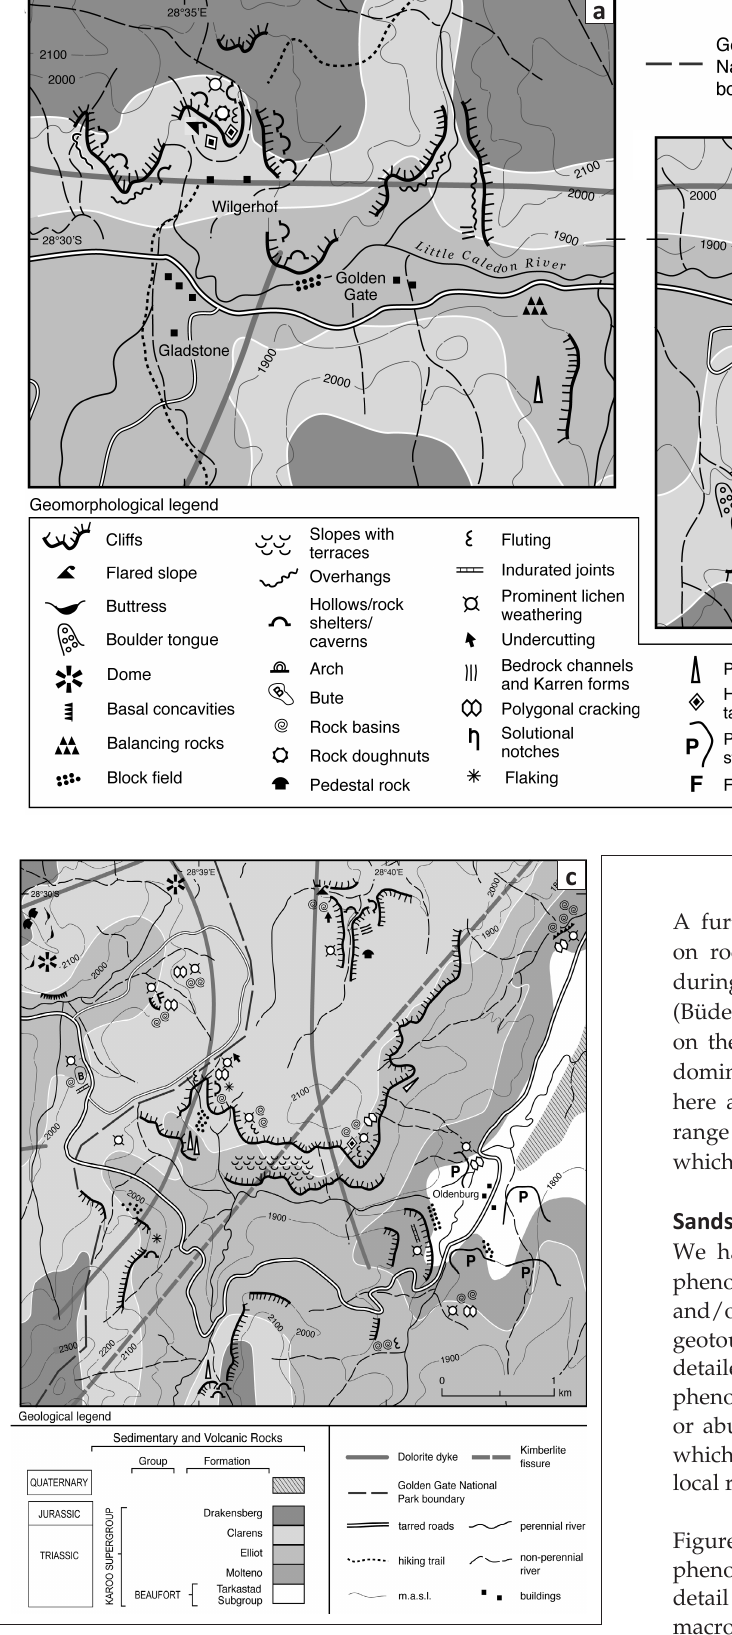
FIGURE 3: Geomorphological map of sandstone phenomena in the Golden Gate Highlands National Park (geological overlays modified after Geological Series 2828 Harrismith, Council for Geoscience, 1998; localities of subfigures a–c as shown in Figure